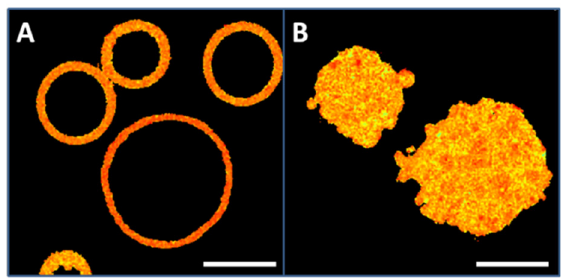
Figure 1. Plasma membrane preparations from CHO cells. ( A ), giant plasma membrane vesicles (GPMV) or blebs. ( B ), PM patches. Bar 10 µm.